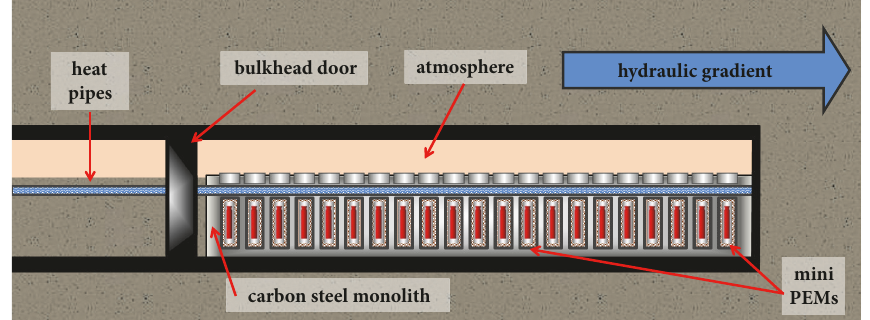
Figure 7: In-cavern